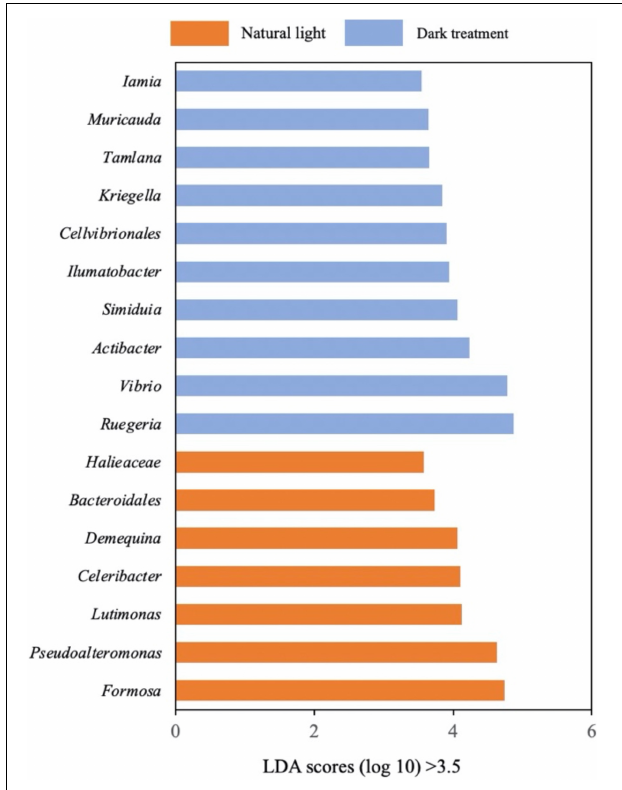
FIGURE 8 | Linear discriminant analysis Effect Size (LEfSe). Differentially abundant bacteria were identified as biomarkers using the Kruskal–Wallis test ( P < 0.05) with a linear discriminant analysis (LDA) score of >